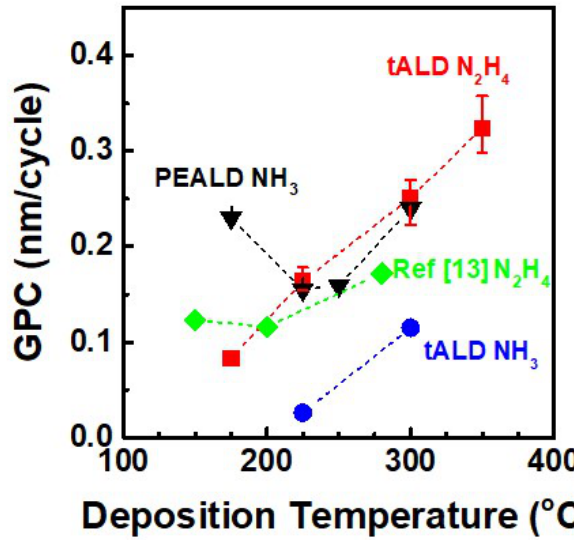
Figure 6. Comparison of growth per cycle (GPC) of AlN thin films deposited using TMA and hydrazine (N 2 H 4 ) and ammonia (NH 3 ), as the metal precursor and nitrogen source, respectively. The AlN films were deposited by using thermal atomic layer deposition (tALD) and plasma-enhanced atomic layer deposition (PEALD) technique. It is also indicated that GPC of AlN thin films deposited using TDEAA and N 2 H 4 , as the metal precursor and nitrogen source [13].